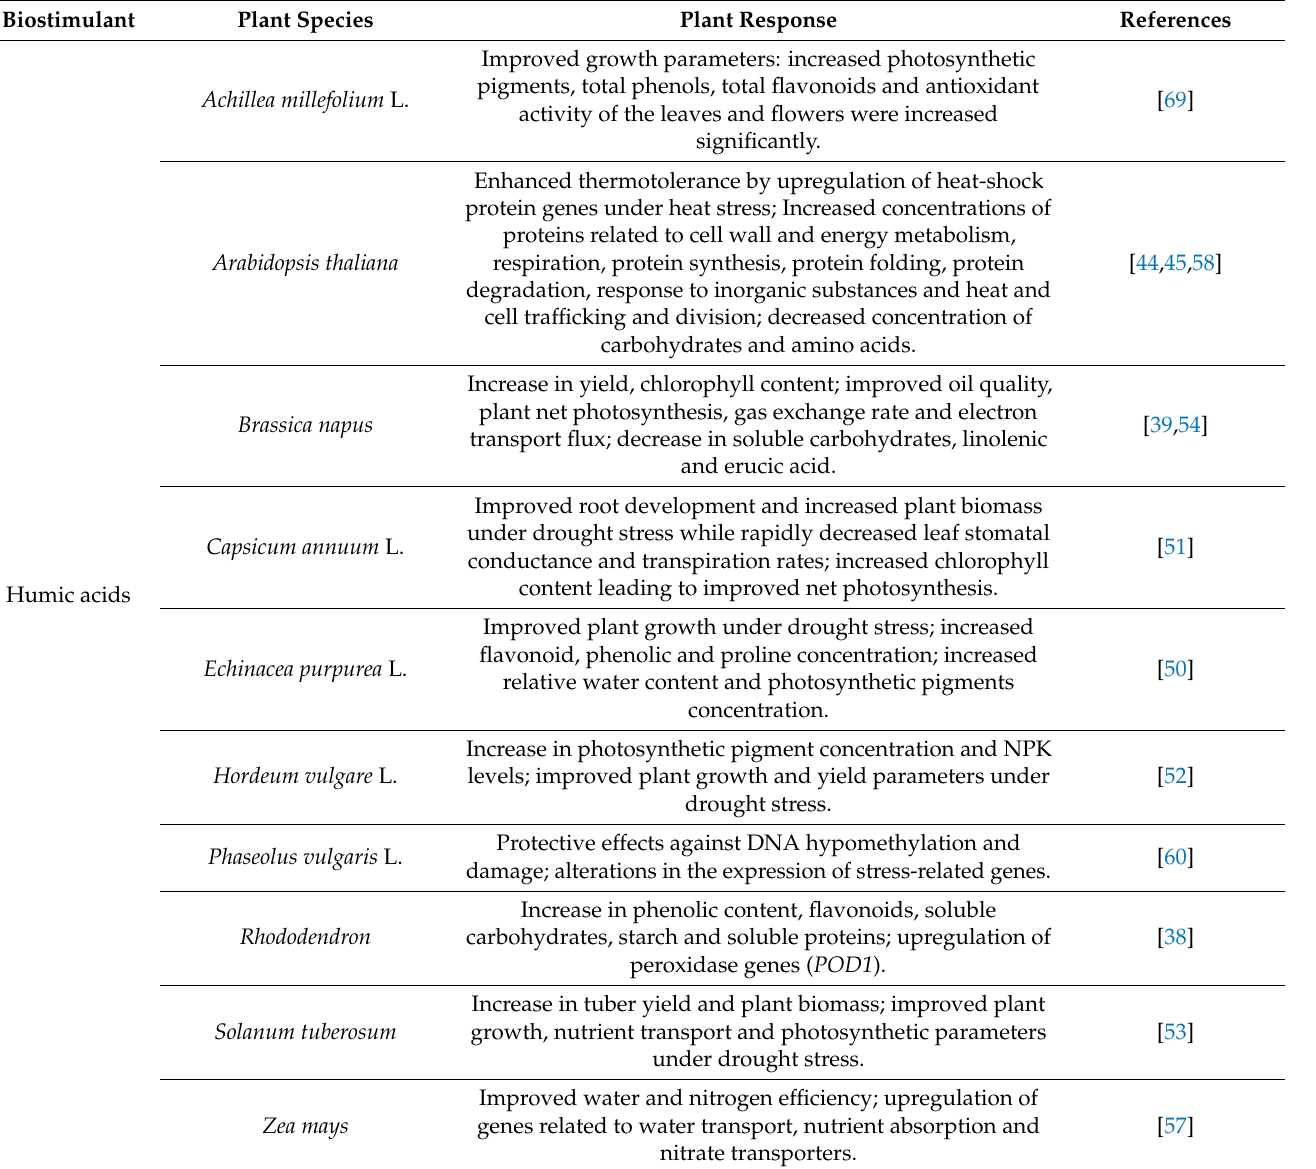
Table 1. Summarized response of different plant species to